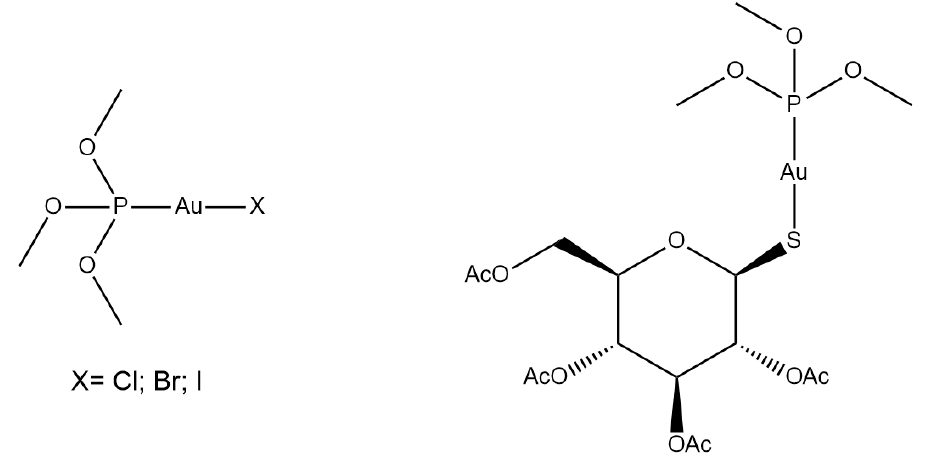
Figure 2. The investigated compounds.